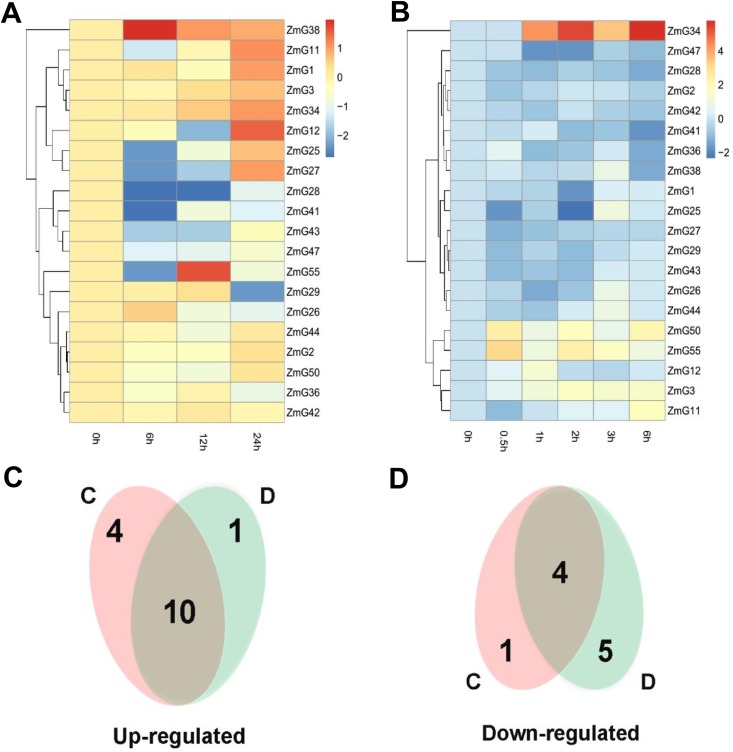
Expression of twenty maize stress-responsive G2-like genes under stress treatments.Three-week-old seedlings were treated with 20% PEG6000 (A) and 4°C (B), respectively. Relative expression levels of the ZmG genes were analyzed by quantitative qPCR, and log2-transformed fold-change values were used for creating the heatmap (original data were shown in S4 Fig). Venn diagram illustrated the distribution of the up-regulated (C) or down-regulated (D) ZmG genes response to cold and drought treatments. The common subset of genes regulated by the two stressed was marked by the overlapping circle.